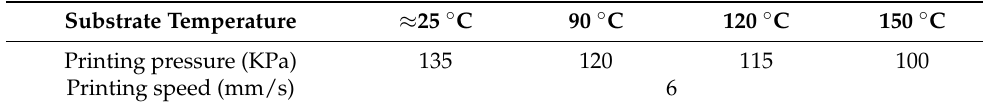
Table 4. Heating-assisted direct writing parameters.